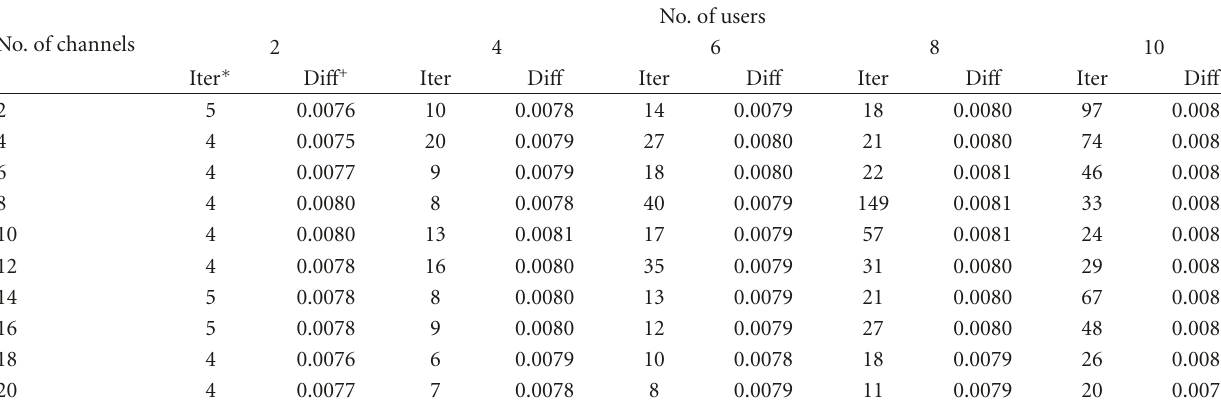
Table 6: Comparisons of CPU time (seconds) required to achieve the budget allocation where competitive equilibrium has balanced individual utilities between two approaches, di ff erence tolerance = 0.01 and average of 10 simulation runs. No. of channels